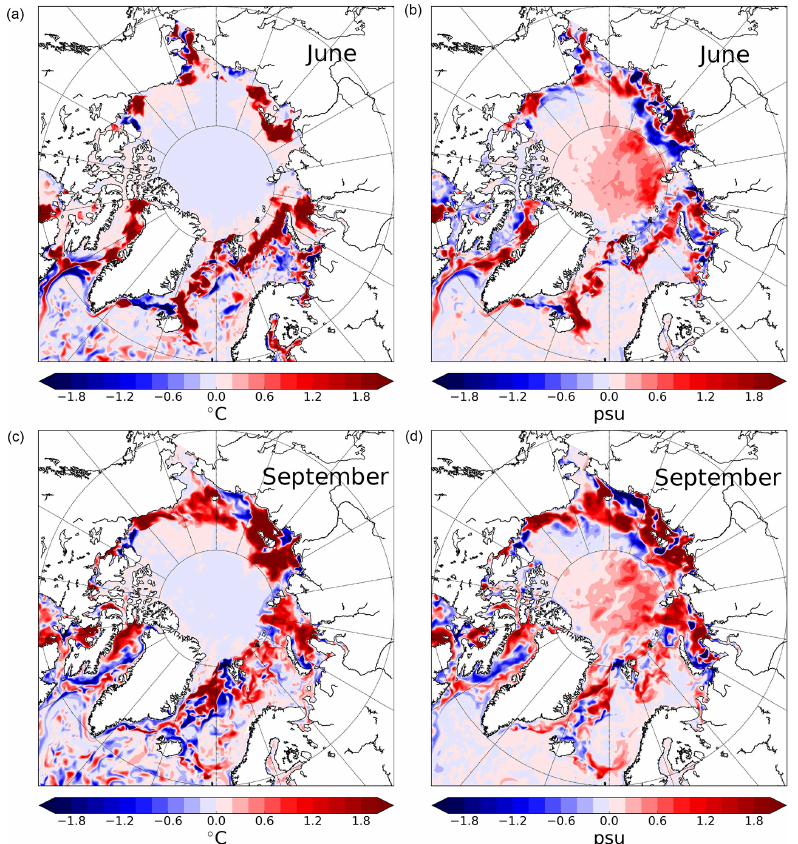
Figure 10. Differences in ocean surface temperature (a, c) and salinity (b, d) between the first-guess and last iteration for June 2005 (a, b) and September 2005 (c, d) .